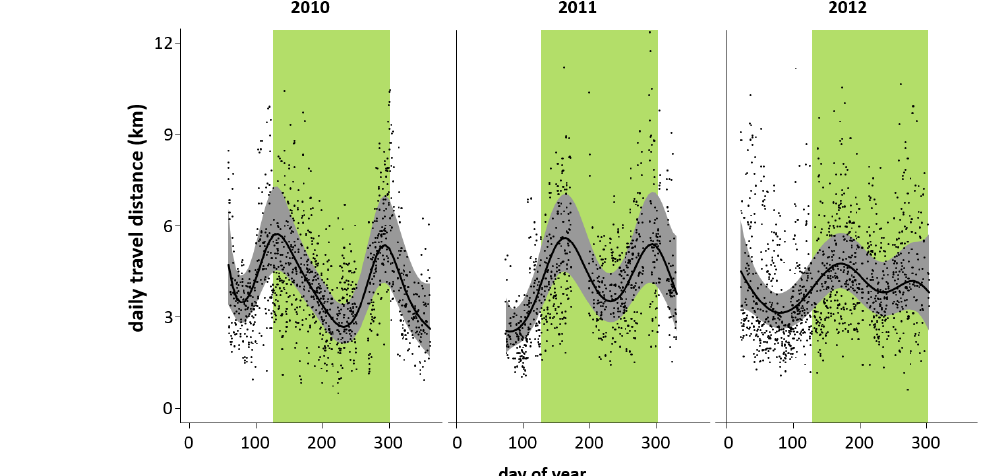
Figure 9. Minimum daily travel distances (DTD) of Guinea baboons in Simenti on a daily temporal scale. Grey dots represent individual DTD values, the black line is the smoothed mean travel path distances derived by the generalized additive model, and the grey shaded area represents the confidence bands at 99%. The green bars indicate the rainy season (June to October).